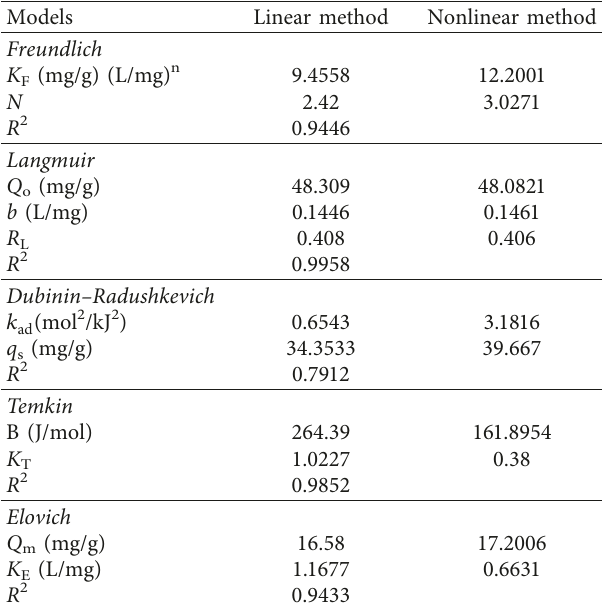
Table 2: Linear and nonlinear parameters of isothermal models for sorption of Cd onto Saccharum arundinaceum Models Linear method Nonlinear